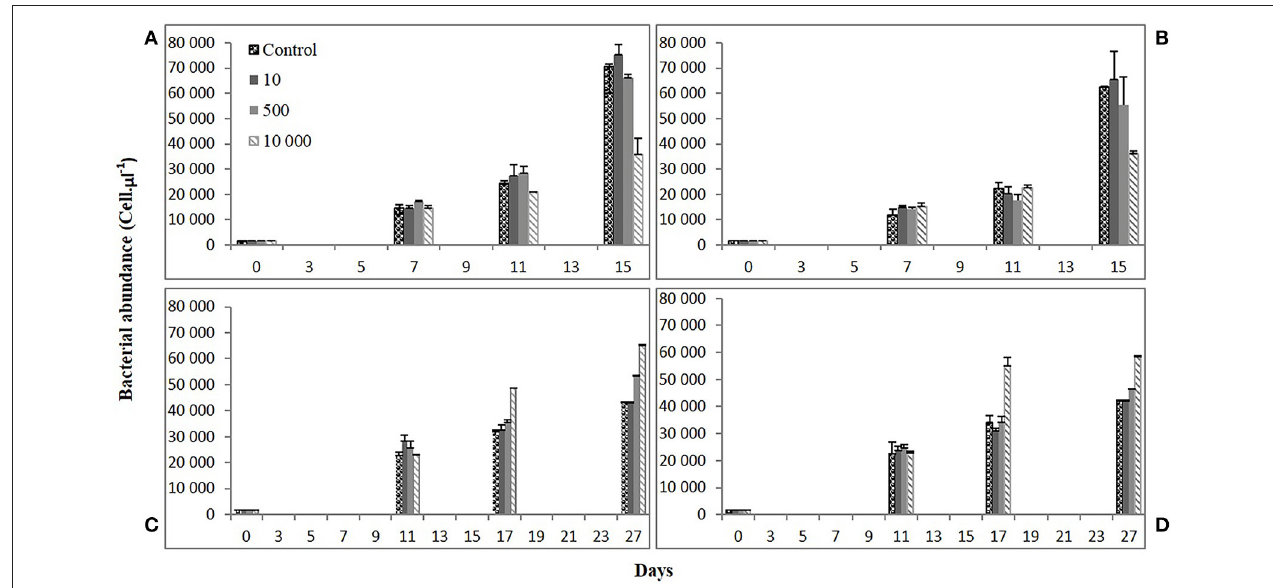
FIGURE 4 | Bacterial abundance (cell µ L − 1 ) along time for Skeletonema costatum (A,B) and Alexandrium catenella (C,D) cultures in four of the desferrioxamine (B) (DFB) treatments selected (Control, 10, 500, 10,000nM). Error bars: standard deviation ( n = 3).